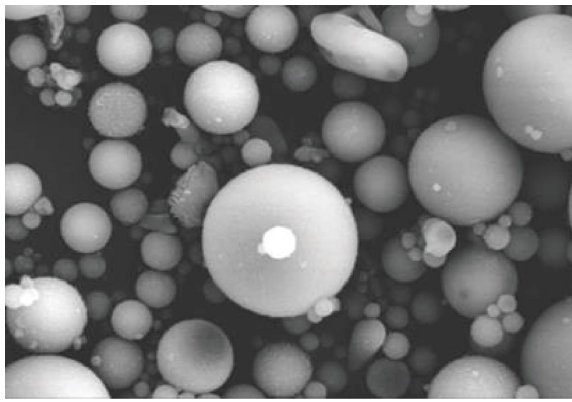
Figure 2: Microstructure of fy ash [25].